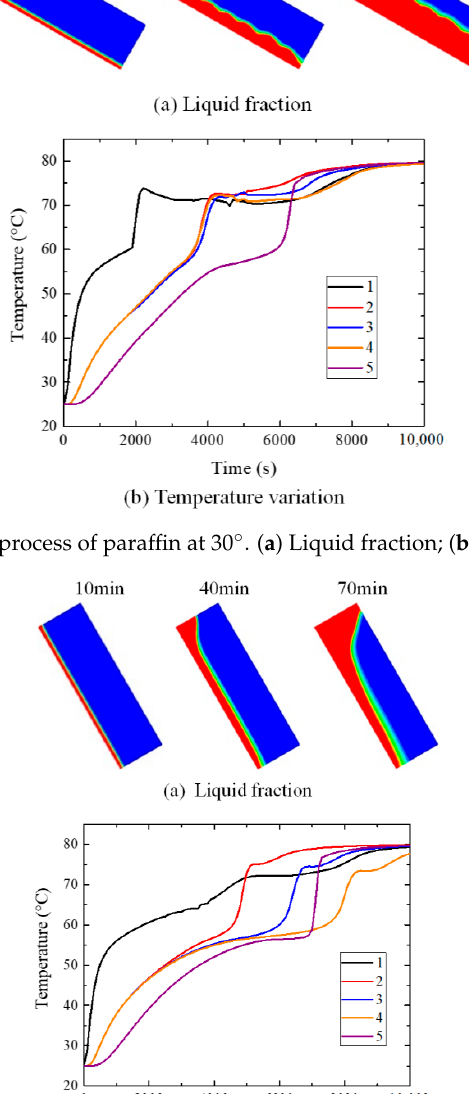
Figure 11. The melting process of paraffin at 60°. ( a ) Liquid fraction; ( b ) temperature variation.